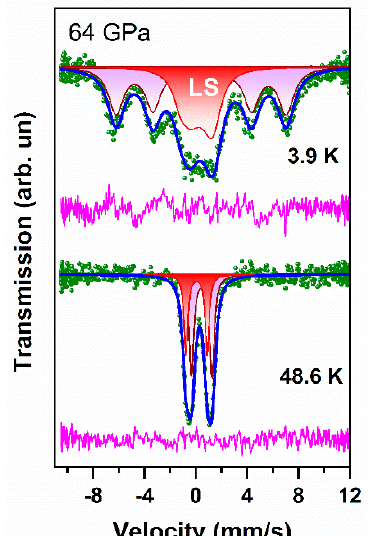
Figure 14. Mössbauer spectra of BNFS at temperatures 3.9 and 48 K shown for comparison in the same scale. Obviousely, the line width in the doublets (at 48 K) is much smaller than the width of the magnetic spectrum at 3.9 K.